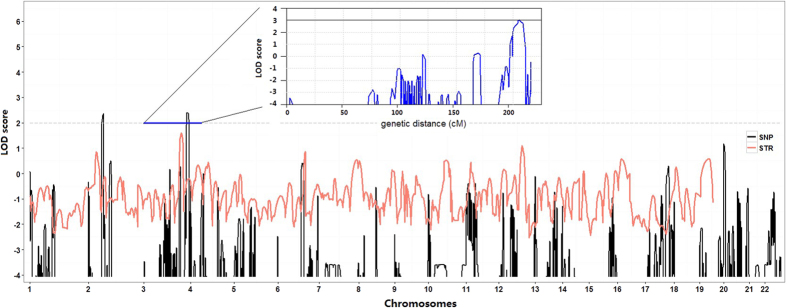
Genome-wide linkage analysis of Family A with PKD.The black and red lines denote LOD values based on SNPs or STRs, respectively. Fine map of Chromosome 3 loci with the addition of six extra STR markers is inset in blue.